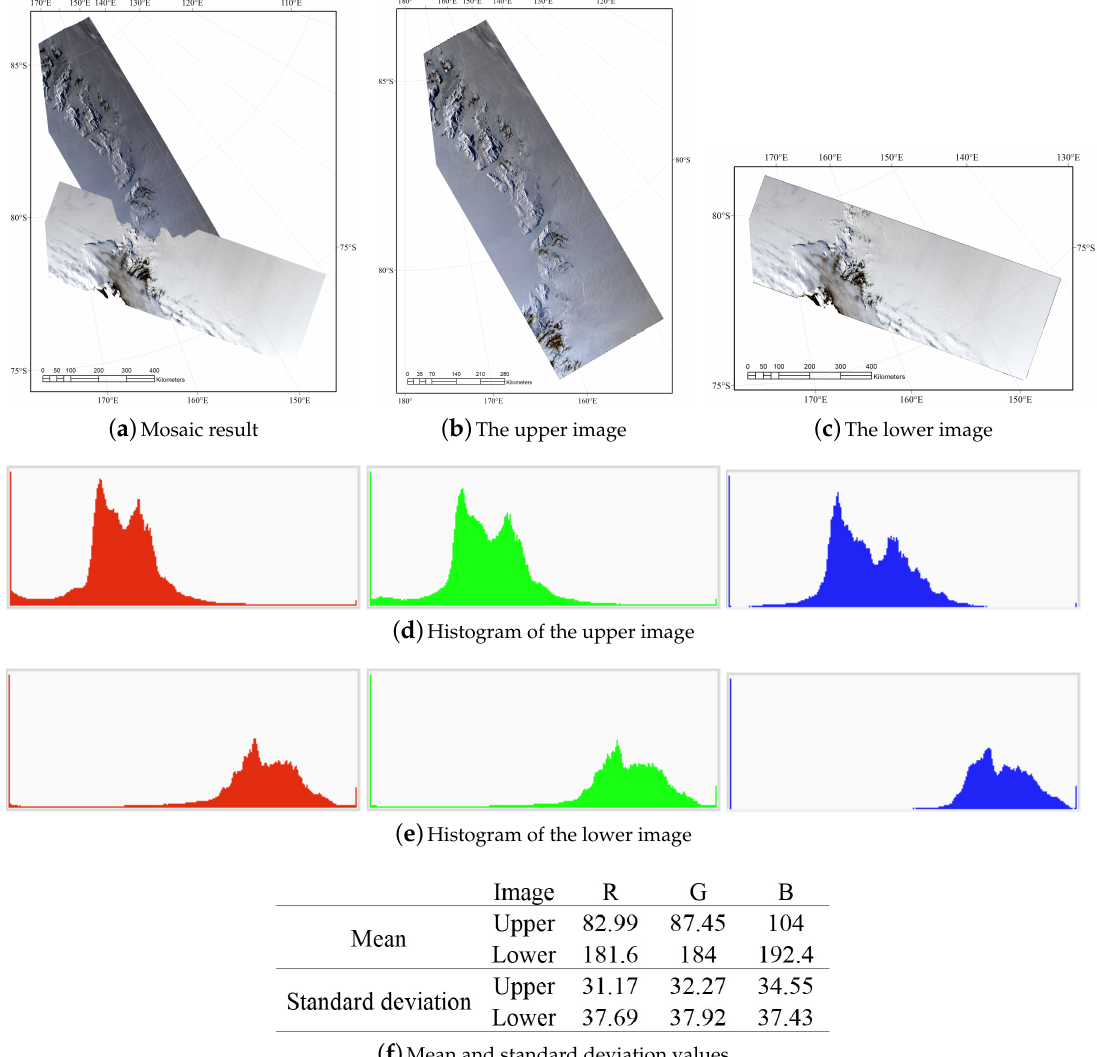
Figure 3. The statistics of two adjacent images randomly selected from the dataset. ( a ) Mosaicked image. ( b ) The upper image. ( c ) The lower image. ( d ) Histogram of the three color channels of the upper image. ( e ) Histogram of the three color channels of the lower image. ( f ) The mean and standard deviation